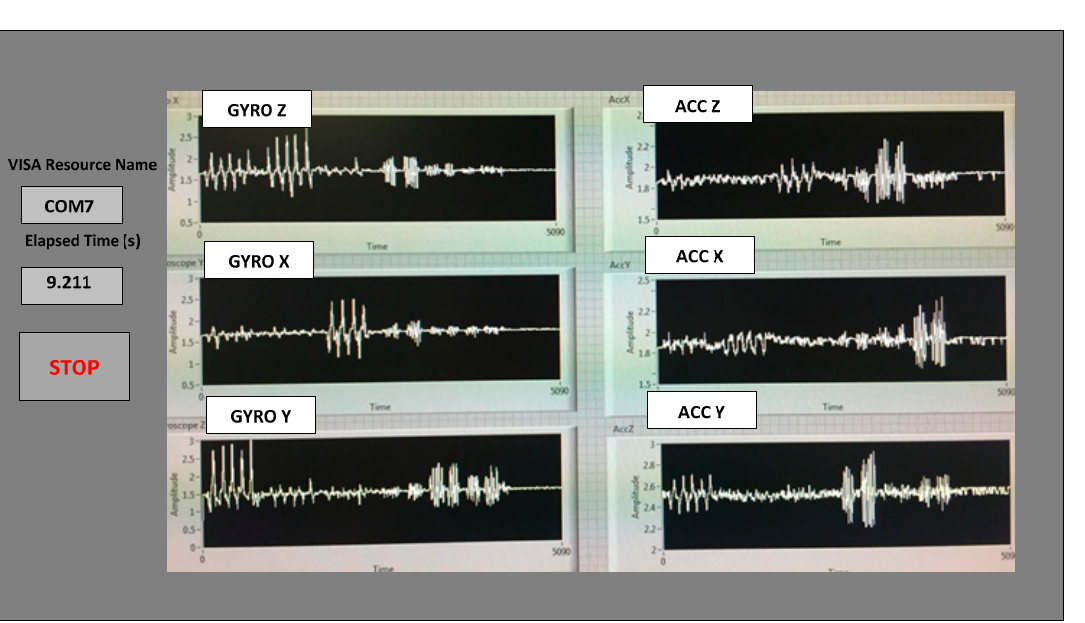
Figure 3. An example output on the LABVIEW GUI of the data wirelessly transmitted from the WGAS to a nearby PC, showing the real-time data for the six monitored signals. For example, the “GYRO X” signal is the angular velocity measured from the gyroscope centered on the X axis, and the “ACC X” signal is the acceleration measured from the accelerometer along the X axis, respectively.